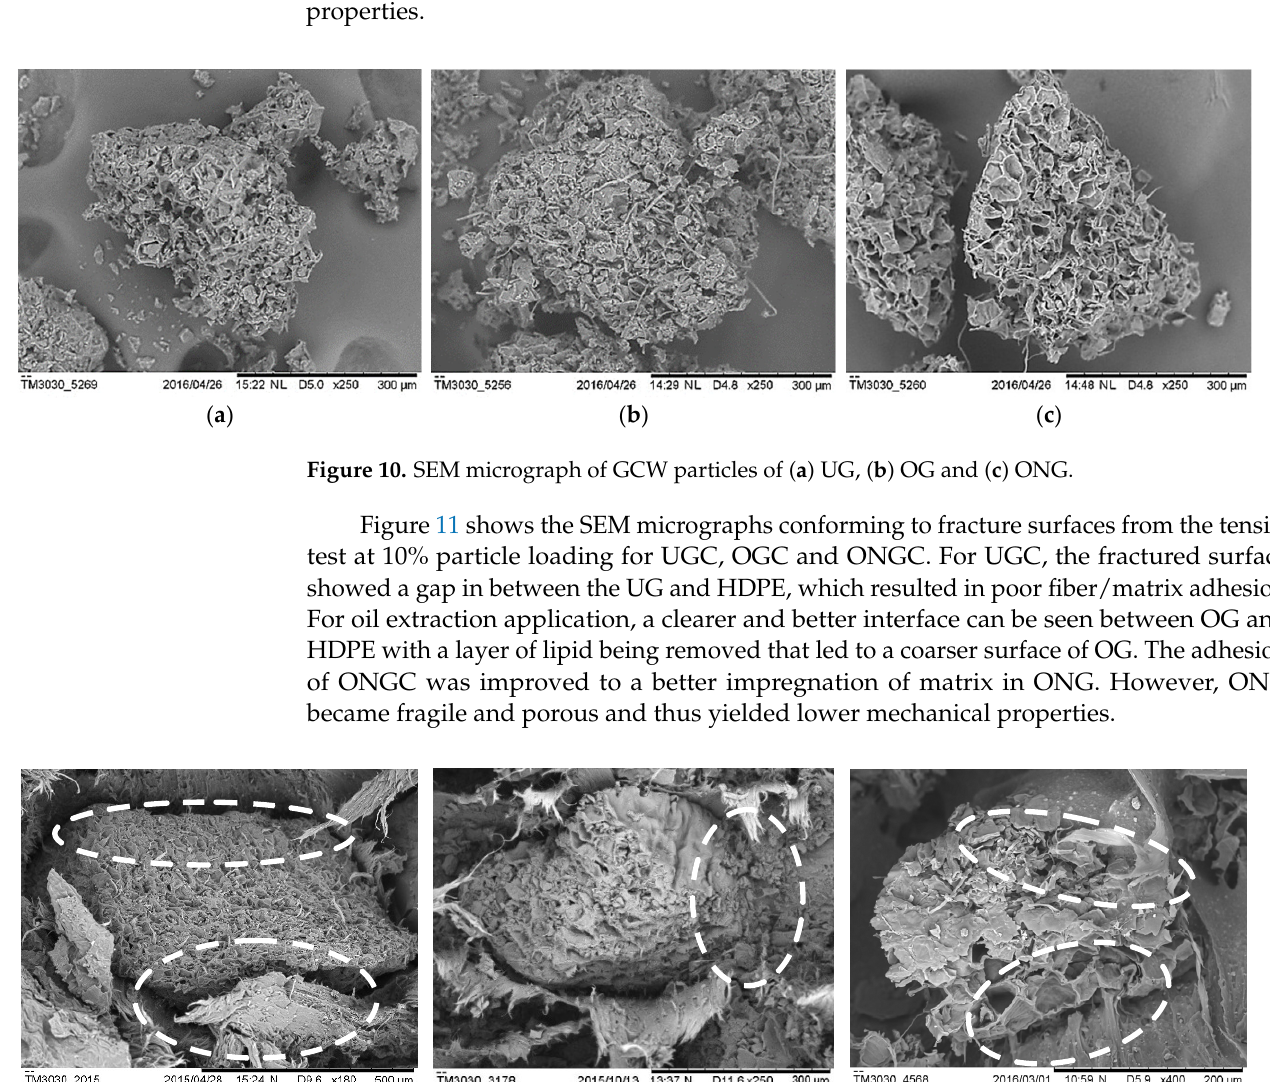
Figure 11. SEM micrograph of breaking surface of ( a ) UGC, ( b ) OGC, ( c ) ONGC (10% particle